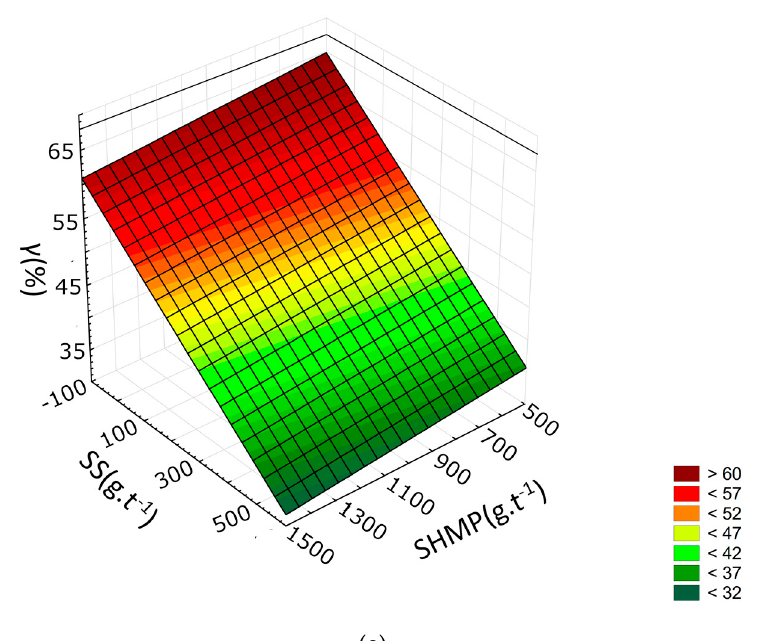
Table 6. Calculated coe ffi cients (based on Equation (4), using the coded values) of the response surfaces with R 2 > 0.9. Froth Yield (%)